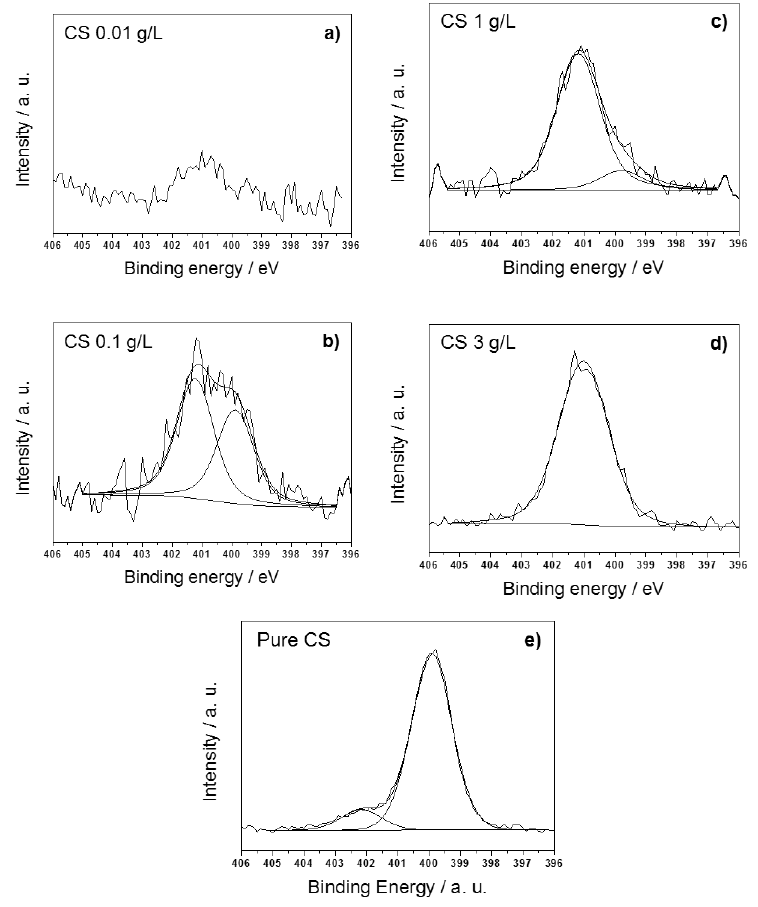
Figure 3. N1s high-resolution regions of freshly-prepared CuNPs-CS nanocomposites synthetized at CS concentration of: ( a ) 0.01 g/L; ( b ) 0.1 g/L; ( c ) 1 g/L; ( d ) 3 g/L; ( e ) pure CS.